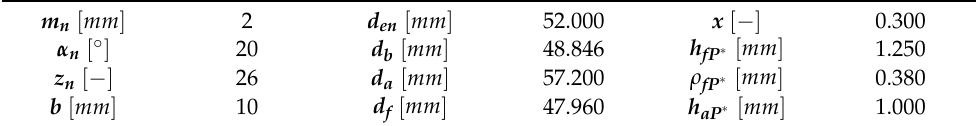
Table 2. Gear data—2 mm-module gear.